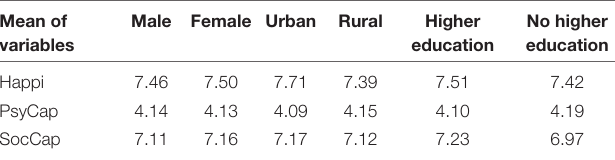
TABLE 3 | Mean analysis of the main variables. Mean of Male Female Urban variables